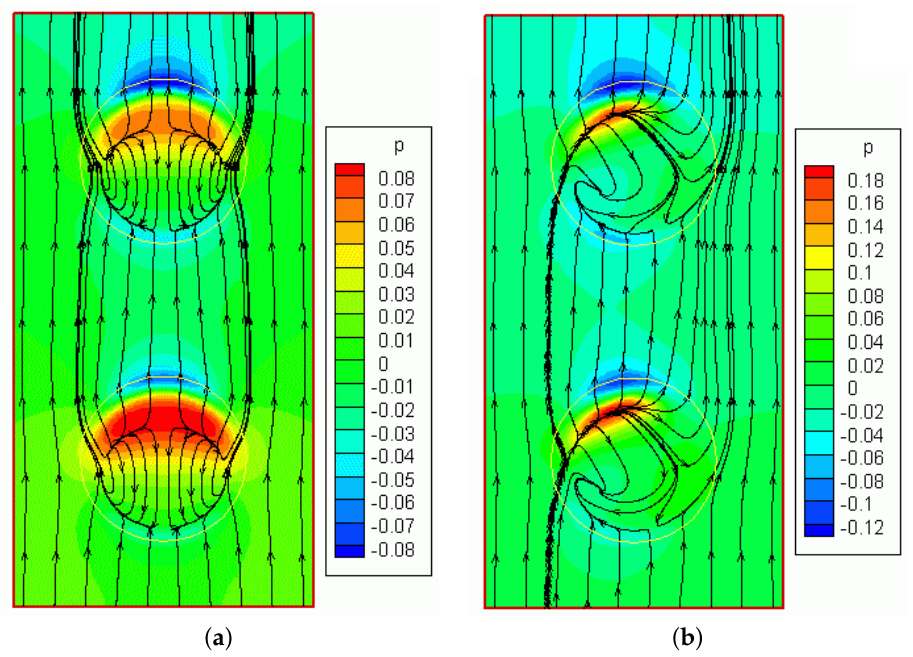
Figure 8. Comparison of patterns of coolant spreading over the wall with spherical dimples 0.1 ( a ) and 0.2 ( b ) deep with applied pressure fields.